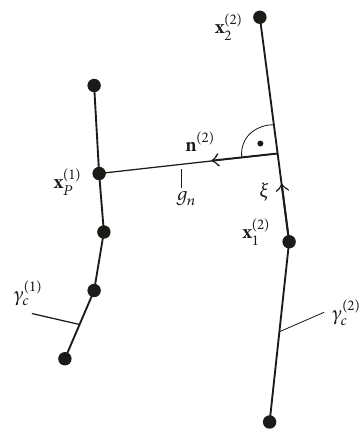
Figure 3: Illustration of the contact zone and the gap